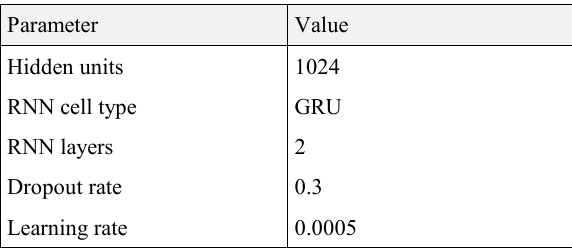
Table 3. Optimal combination of network and training parameters